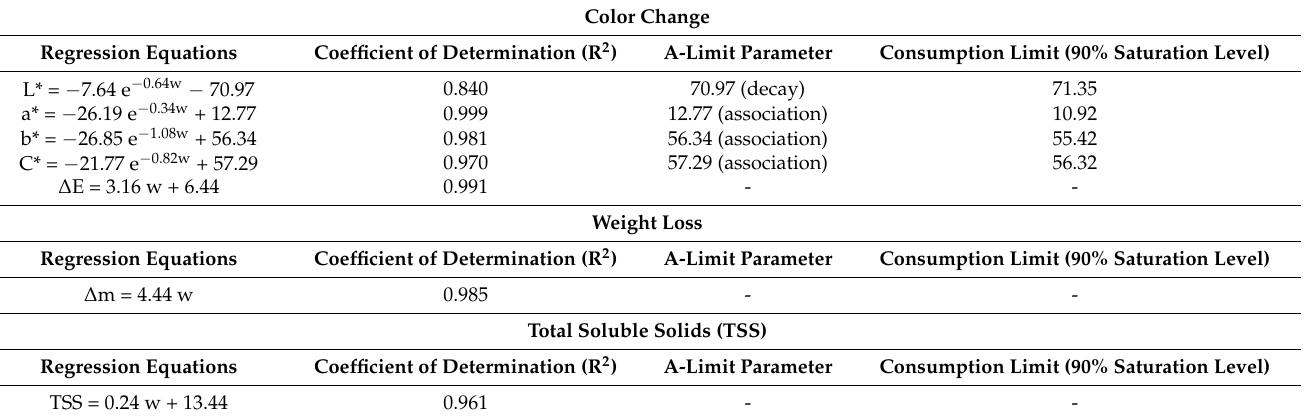
Table 2. Regression equations regarding the storage period with their corresponding coefficient of determination (R 2 ) for measured quality